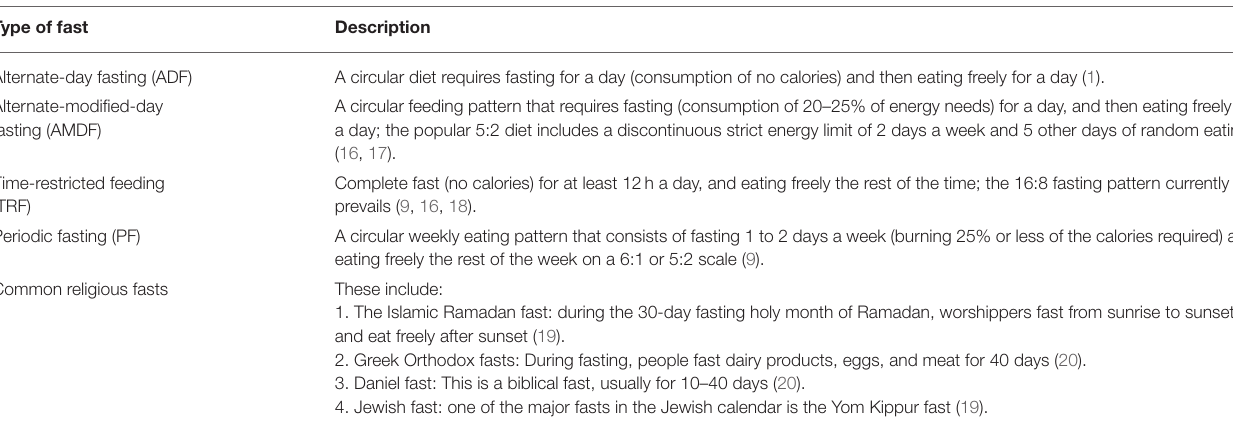
TABLE 1 | Types of intermittent fasting and